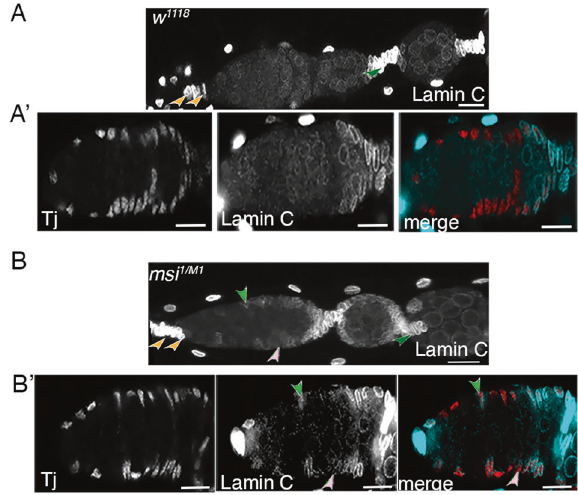
Fig. 6 Losing Msi function from somatic cells results in mis- expression of Lamin C. A - A ’ Representative confocal micrographs (projection of 3 planes from a z stack) showing normal Lamin C expression in TFs and CCs (orange arrowheads) and stalk cells (green arrowhead) in a wild-type germarium. B - B ’ Confocal micrographs (projection of 3 planes from a z stack) showing up-regulation of Lamin C in somatic cells in germaria dissected from msi 1/M1 adults. Ovarioles were dissected from a minimum of 5 adult fl ies and imaged randomly. A layer 1 FSC (light pink arrowhead) and posterior EC (green arrowhead) expressing Lamin C are labelled. Scale bars, 10